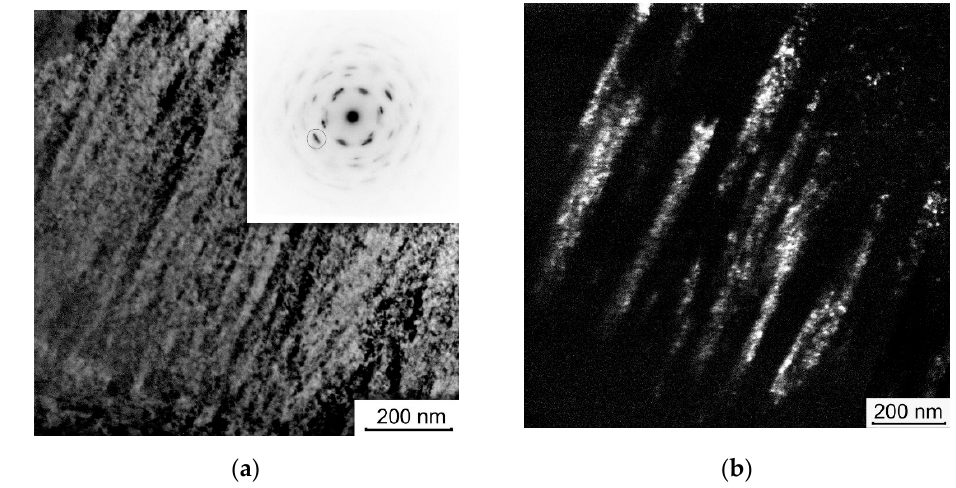
Figure 1. Bright-field electron microscopy images ( a ) of the coating microstructure of the TZ1SMC specimens with a microdiffraction pattern from the central coating area(inset); dark-field images ( b ), (200)-type reflection) from the cubic structure of the δ —(Ti,Zr)N—encircled with an ellipse.